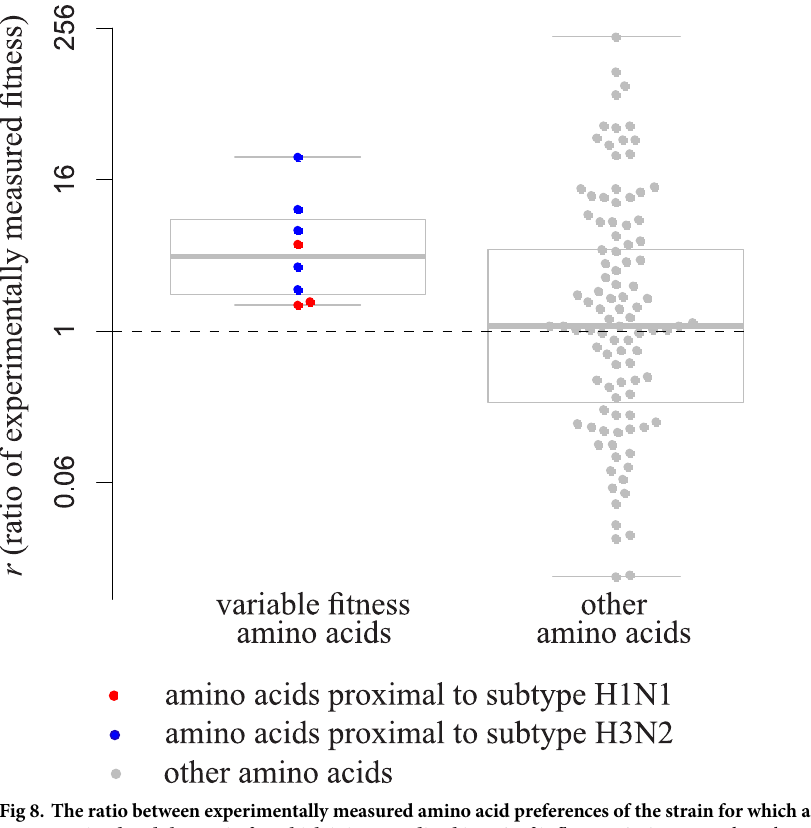
Fig 8. The ratio between experimentally measured amino acid preferences of the strain for which an amino acid is more proximal and the strain for which it is more distal in HA of influenza A. Amino acids with significant (left, p < 0.05 for both strains) or insignificant (right, p > 0.1 for both strains) changes in the phylogenetic analysis are shown; notations are the same as in Fig 4.